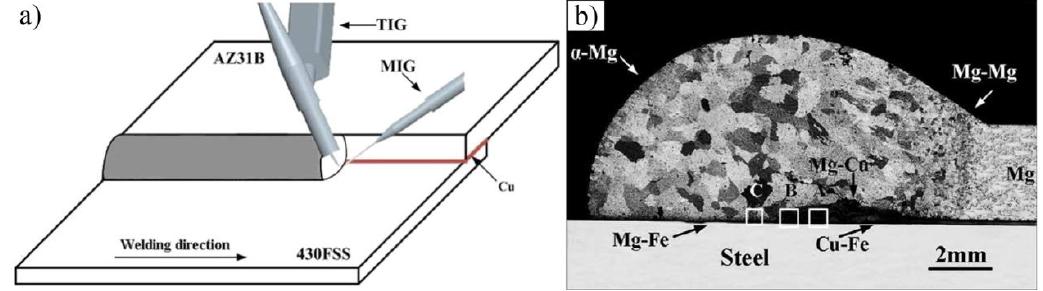
Figure 19. TIG-MIG hybrid welding with Cu interlayer [65] ( a ) schematic diagram; ( b ) cross-section photograph of the joints with 0.1 mm Cu interlayer.